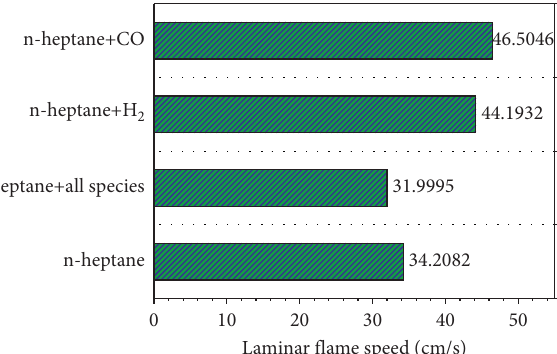
Figure 9: Laminar flame speed of mixtures of different reforming species and n-heptane.